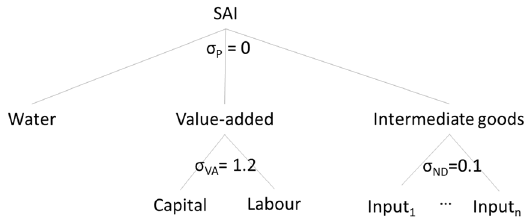
Figure 3. Production function of non-agricultural self-abstracting industries. The zero elasticity at the top-level indicates that production is not possible without water inputs.